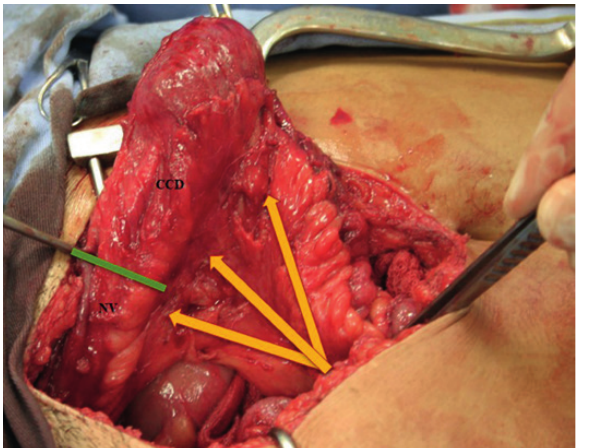
figure 2 - The neobladder is shown exposed and released from its adhesions. The yellow arrows indicate the vascular pedicles, which were used to identify the level of division (green line) between the future neovagina (Nv) and the continent cutaneous urinary diversion (ccD).